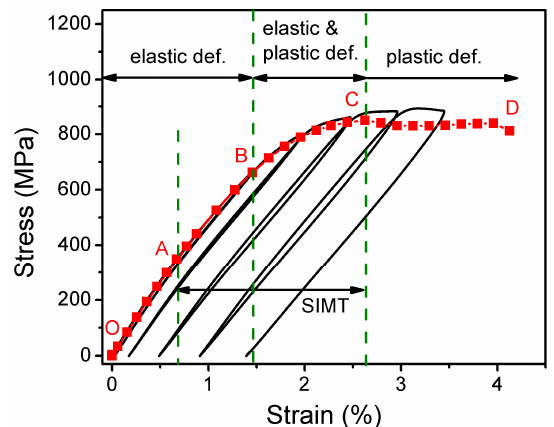
Figure 9. Domains of occurrence of different deformation mechanisms noted on conventional stress–strain curves for Ti36Nb5Zr alloy. “def” is the abbreviation of “deformation”.